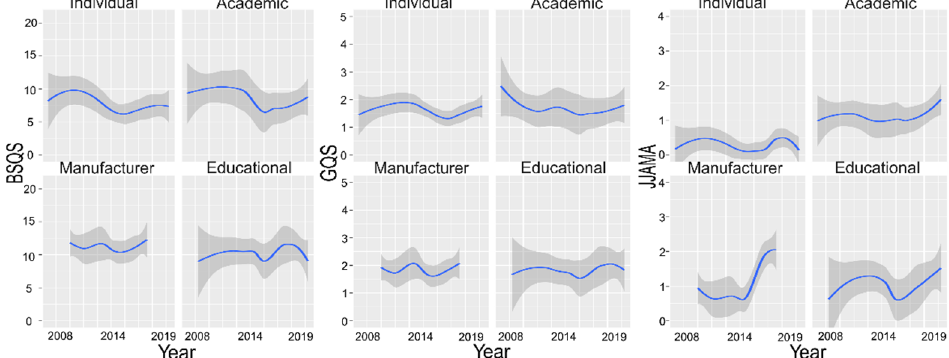
Figure 3. Changes of BSQS, GQS, and JAMAS by year according to sources. The smoothed loess regression represents the changes of scores from 2005 to 2019.